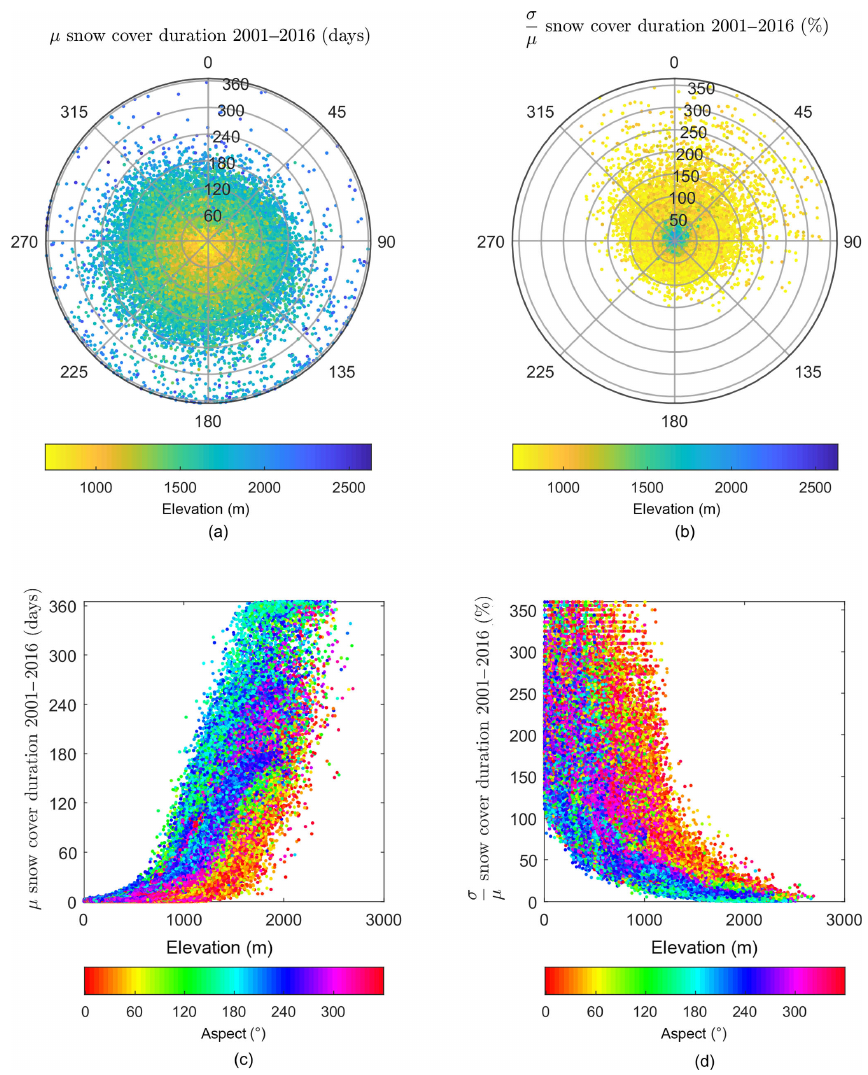
Figure 7. Mean SCD (a, c) and associated coefficient of variability ( σ a random sub-sample of 50000 pixels is displayed in the